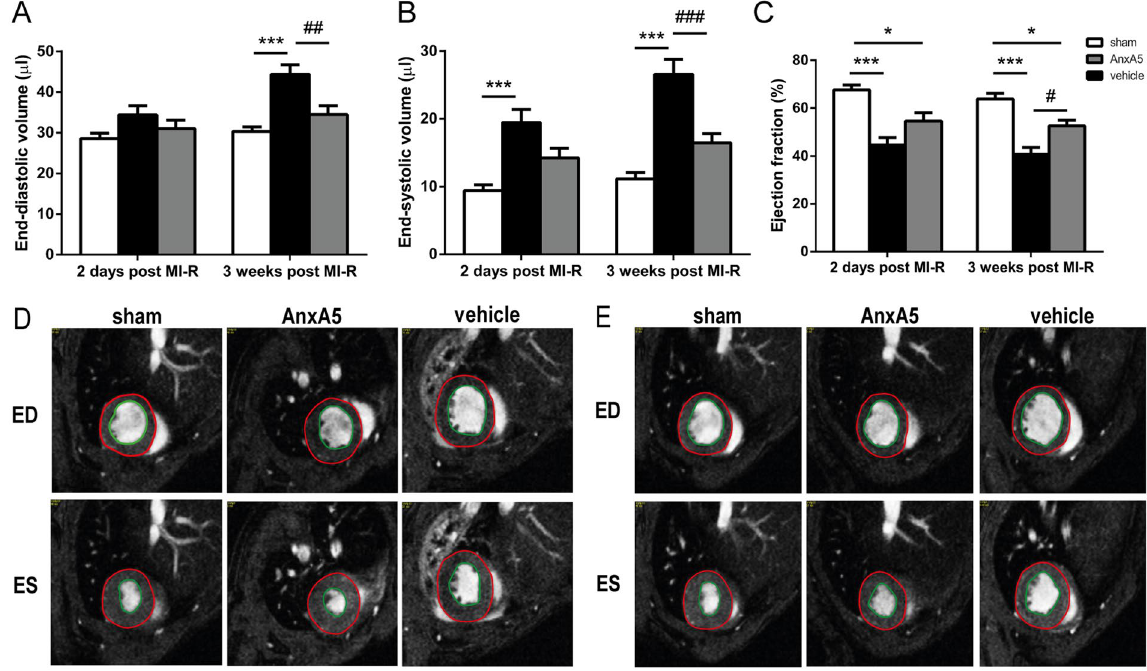
Figure 3. Cardiac MR imaging of LV volumes and function. Assessment of LV volumes and function two days and three weeks after MI-R (n = 12–15). AnxA5 therapy prevented the increase in end-diastolic volume (EDV) ( A ) and end-systolic volume (ESV) ( B ) accompanied by a preserved ejection fraction (EF) ( C ) as compared to vehicle three weeks post MI-R. Representative transversal short-axis MR images at end-diastole (ED) and end-systole (ES) two days ( D ) and three weeks ( E ) following MI-R in the sham, AnxA5 and vehicle groups, red line indicates epicardial border and green line indicates endocardial border. Data are mean ± SEM. # P < 0.05, ## P < 0.01, ### P < 0.001 all vs. vehicle, * P < 0.05 and *** P < 0.001 both vs.